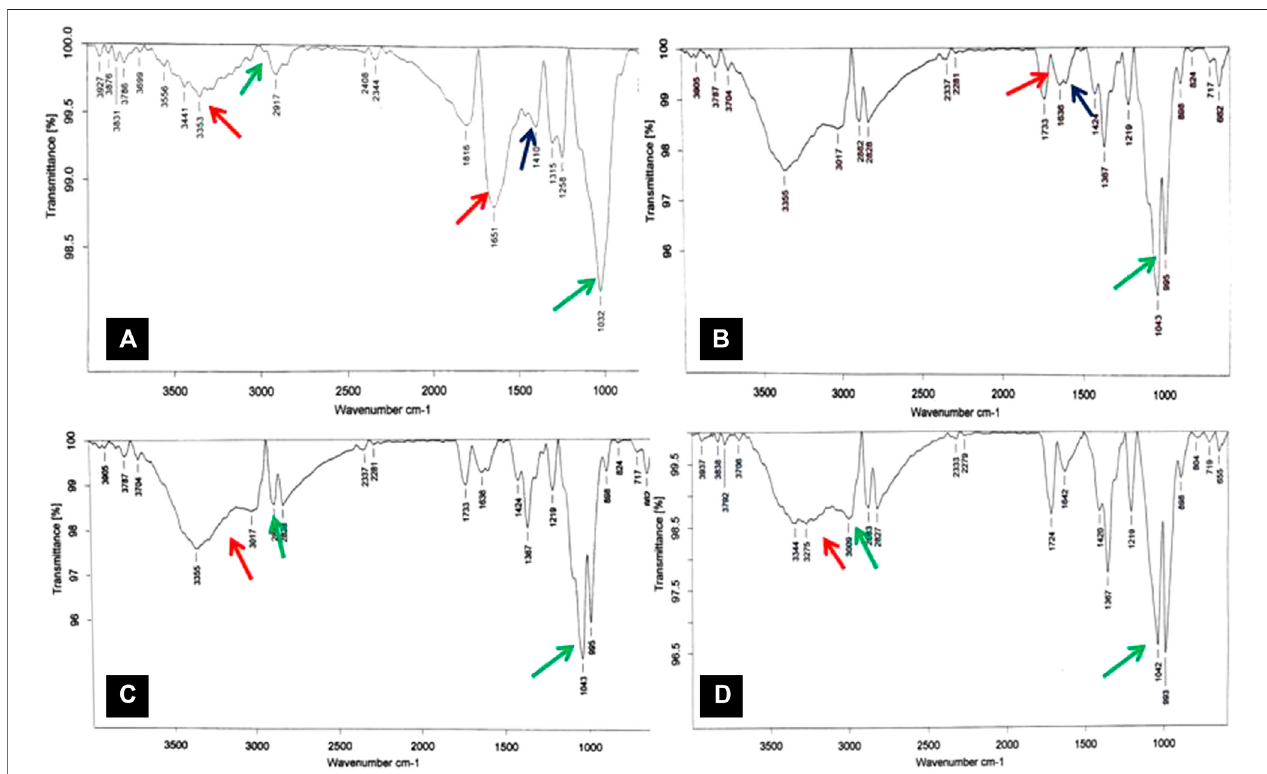
FIGURE 8 | FTIR spectra of different chemical-treated corn cob residues, (A) spectra of raw corn cob biomass, (B) spectra of NaOH-pretreated residues, (C) spectra of HNO 3 -pretreated residues, and (D) spectra of sequential NaOH-pretreated and acid-hydrolyzed